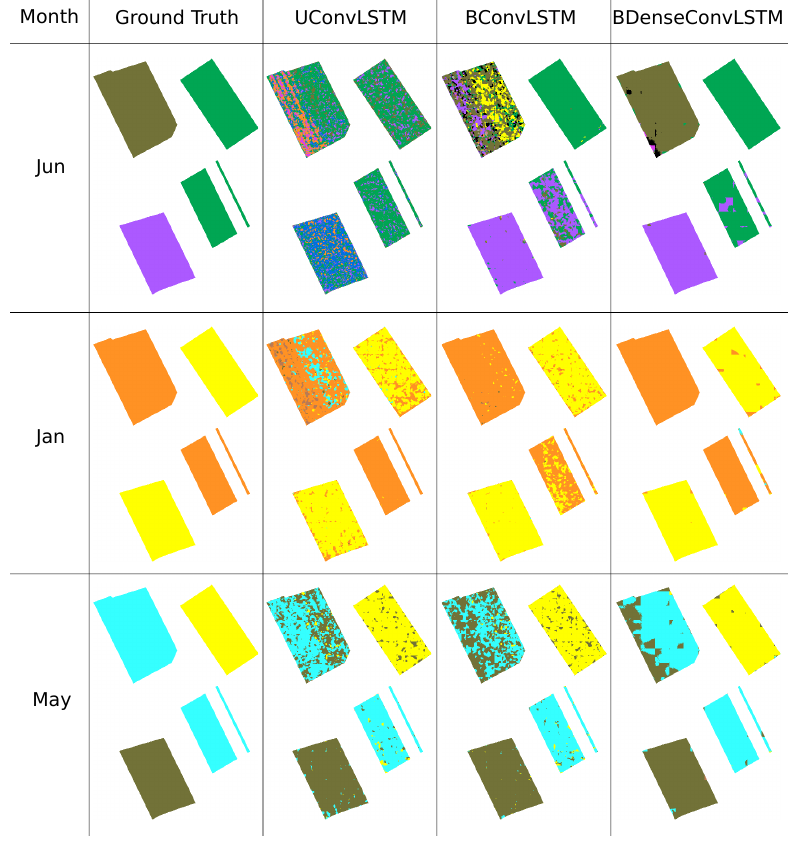
Figure 12. Sample structured output for